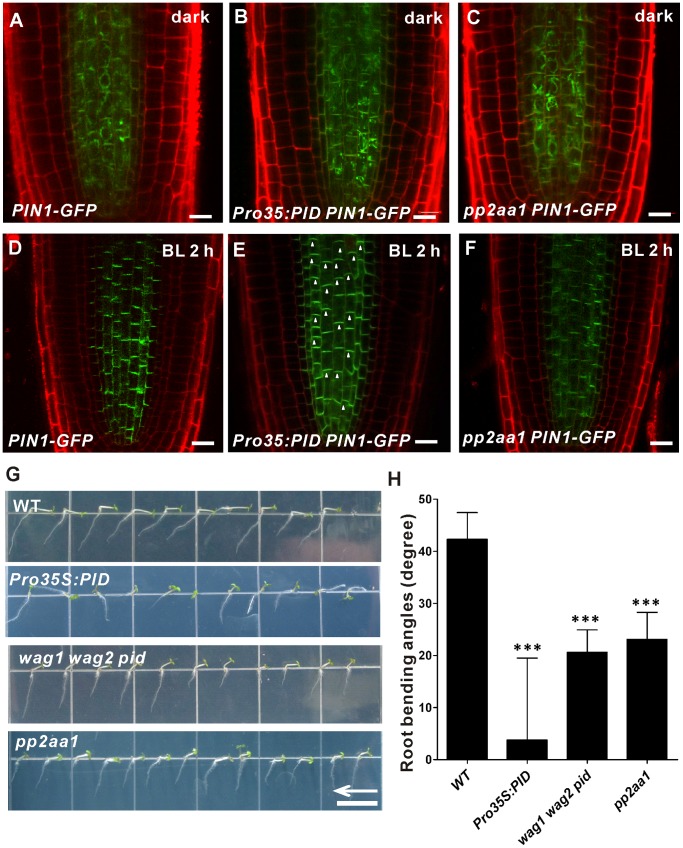
Blue-light-induced PIN1 distribution is mediated by PID/PP2A.(A–F) PIN1 localization, as revealed by GFP fluorescence, in the steles of 4-day-old etiolated PIN1::PIN1-GFP (A, D), PIN1::PIN1-GFP Pro35S:PID (B, D), and PIN1::PIN1-GFP pp2aa1 (C, F) seedlings grown in darkness (A–C) or under blue light (D–F) (10 µmol m−2sec−1) for 2 h. At least twelve seedlings were imaged per line for each of three replicates. Arrowheads show the apical plasma membrane localization of PIN1 in Pro35S:PID seedlings under blue light illumination. Arrows indicate blue light direction. Bars = 20 µm. (G) Images of 2-day-old etiolated seedlings of the wild-type, Pro35S:PID, wag1 wag2 pid and pp2aa1 mutants grown on vertical plates, and then exposed to unilateral blue light (10 µmol m−2sec−1) for another 48 h. The arrows indicate the direction of blue light. Bar = 1 cm. (H) Root bending angles of mutants. The bending angles of the roots away from the vertical direction were measured after 48 h unilateral blue light illumination and average curvatures were calculated. Values are the average of three biological replicates (n >10 per time point on each replicate). Error bars represent SE and *** indicate significant difference at P<0.001, as determined by Student’s t-test.